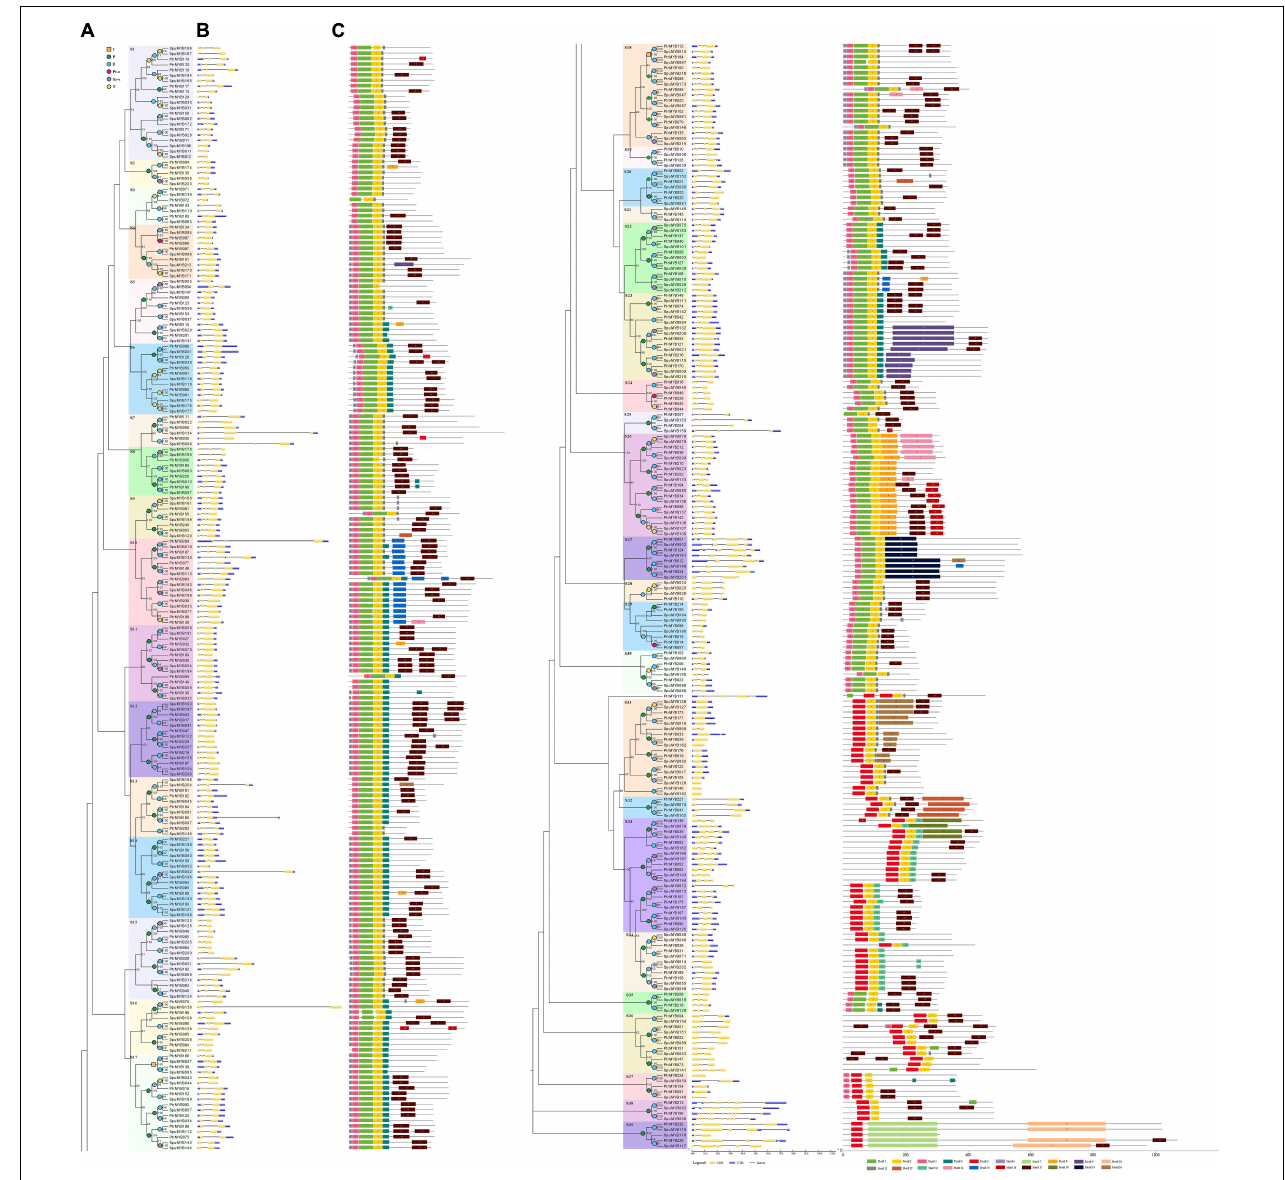
FIGURE 2 | Phylogenetic relationships, gene structure, and motif composition of poplar and willow R2R3 MYB genes. (A) The phylogenetic tree was constructed with MAGE X64 using the Neighbor-Joining (NJ) method, with 1,000 bootstrap replicates based on multiple alignments of the full-length amino acid sequences of 192 R2R3 MYB genes from poplar and 216 R2R3 MYB genes from willow; this tree shows 39 subgroups (S1-S39) with high bootstrap values marked with colored backgrounds. Bootstrap values below 50 are not shown in the phylogenetic tree. Only one protein was not assigned to any subgroup. (B) GSDS was used to analyze the exon-intron structures of the R2R3 MYB genes. Exons and introns are indicated by yellow boxes and single black lines, respectively. Untranslated upstream and downstream regions are indicated by dark-blue bars at the ends of the sequence. The length of each R2R3 MYB gene can be estimated using the bottom scale. (C) Schematic representation of conserved motifs in 39 subgroups of poplar and willow R2R3 MYB proteins elucidated using MEME. Each motif is represented by a number in colored boxes. Black lines represent non-conserved sequences. The size of each motif can be estimated using the scale at the bottom. Motif sequences are listed in Supplementary Table 8 . The numbers of conserved motifs in poplar and willow are shown in Supplementary Figure 3 . The colored squares (duplication events) and circles (triplication events) placed on nodes represent gene lineage expansion(s) that can be associated with particular ancient polyploid events: γ , P, β , Pt- α , Sp- α . Positions are in